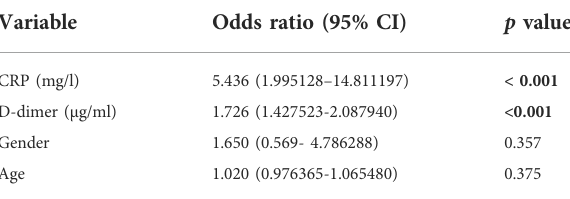
TABLE 2 Logistic regression analysis predictive of mortality in COVID- 19 patients.